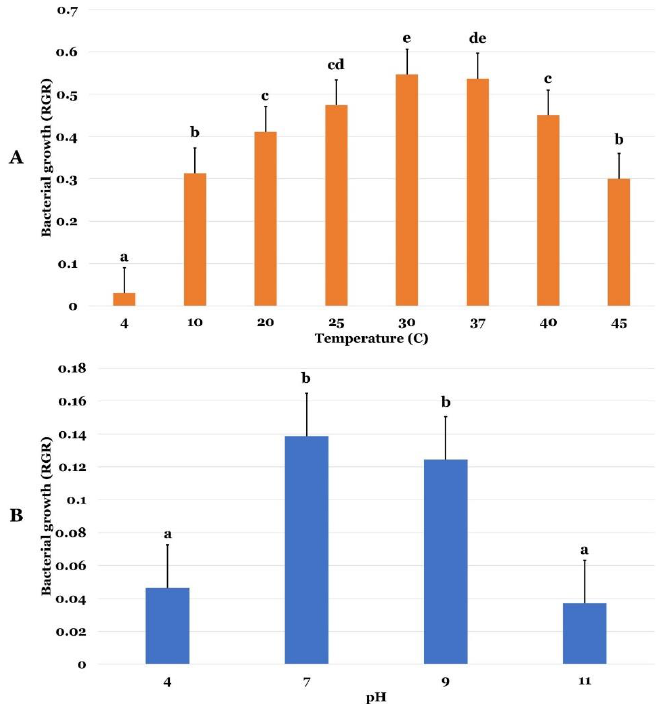
Figure 1. Growth performance of P. agglomerans strain Pa to temperature and pH stresses. ( A ) Temperature e ff ect on relative growth rate (RGR) of bacterium. ( B ) pH e ff ect on RGR bacterial growth. Data present the mean of three repetitions ± standard error. One-way ANOVA was performed by using SPSS 22 and subsequent Tukey’s multiple comparison post-test. Points highlighted with di ff erent letters indicate significant di ff erences among the treatments ( p <